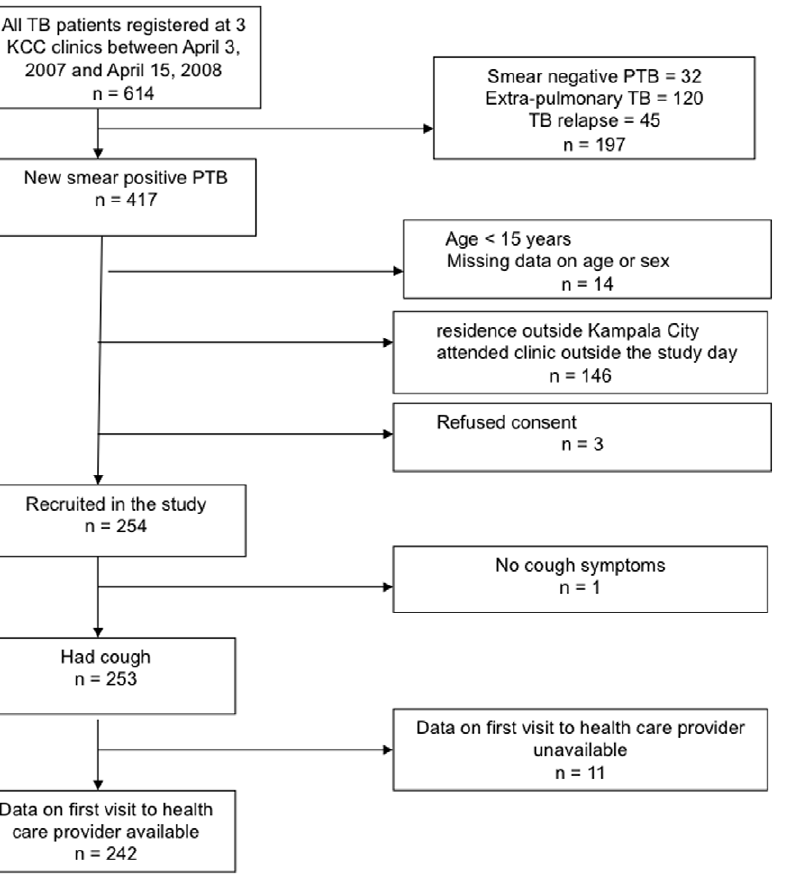
Figure 1. Flowchart showing the patients included in the analysis of diagnostic delay in Kampala, Uganda 2007-8. Legend: KCC=Kampala City Council, TB=Tuberculosis, PTB=Pulmonary tuberculosis.